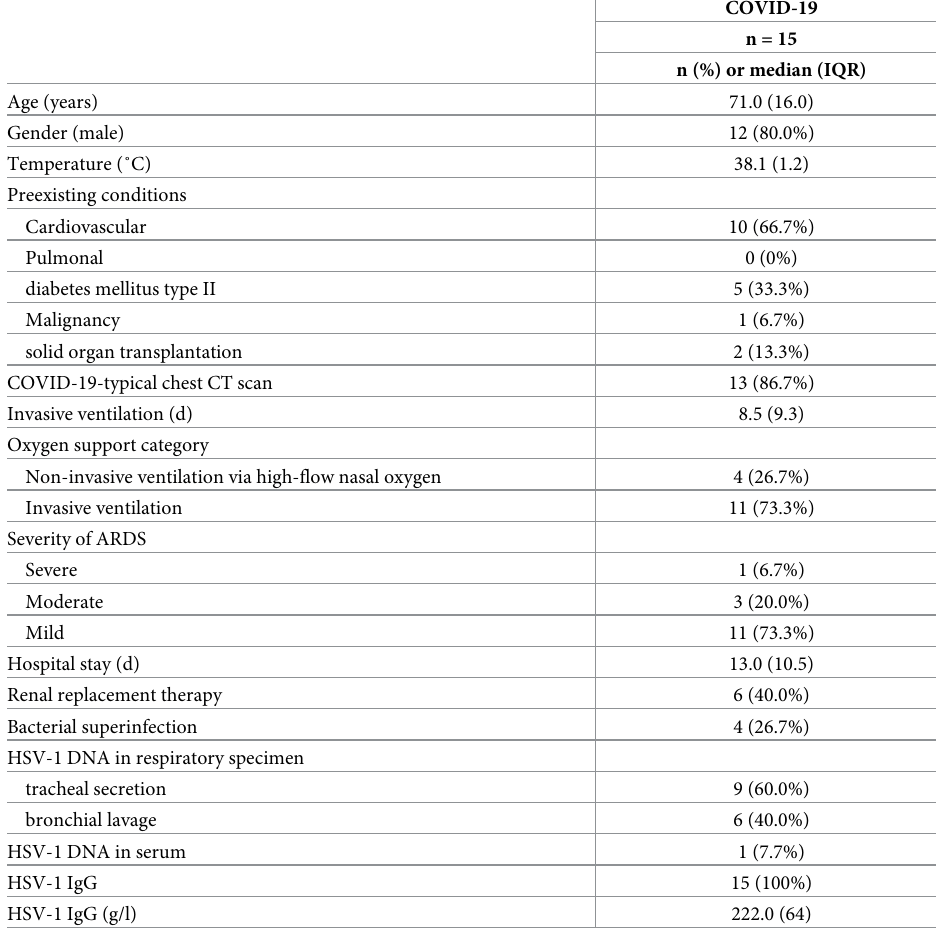
Table 1. Demographics of study population at first HSV-1 detection in TS or